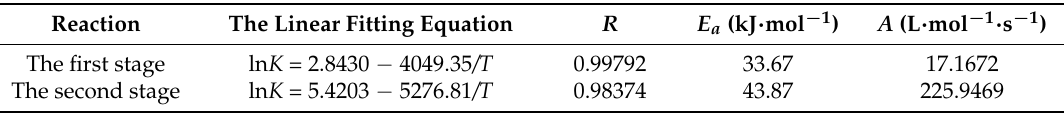
Table 4. The parameters for the two-separate-stage kinetic model.